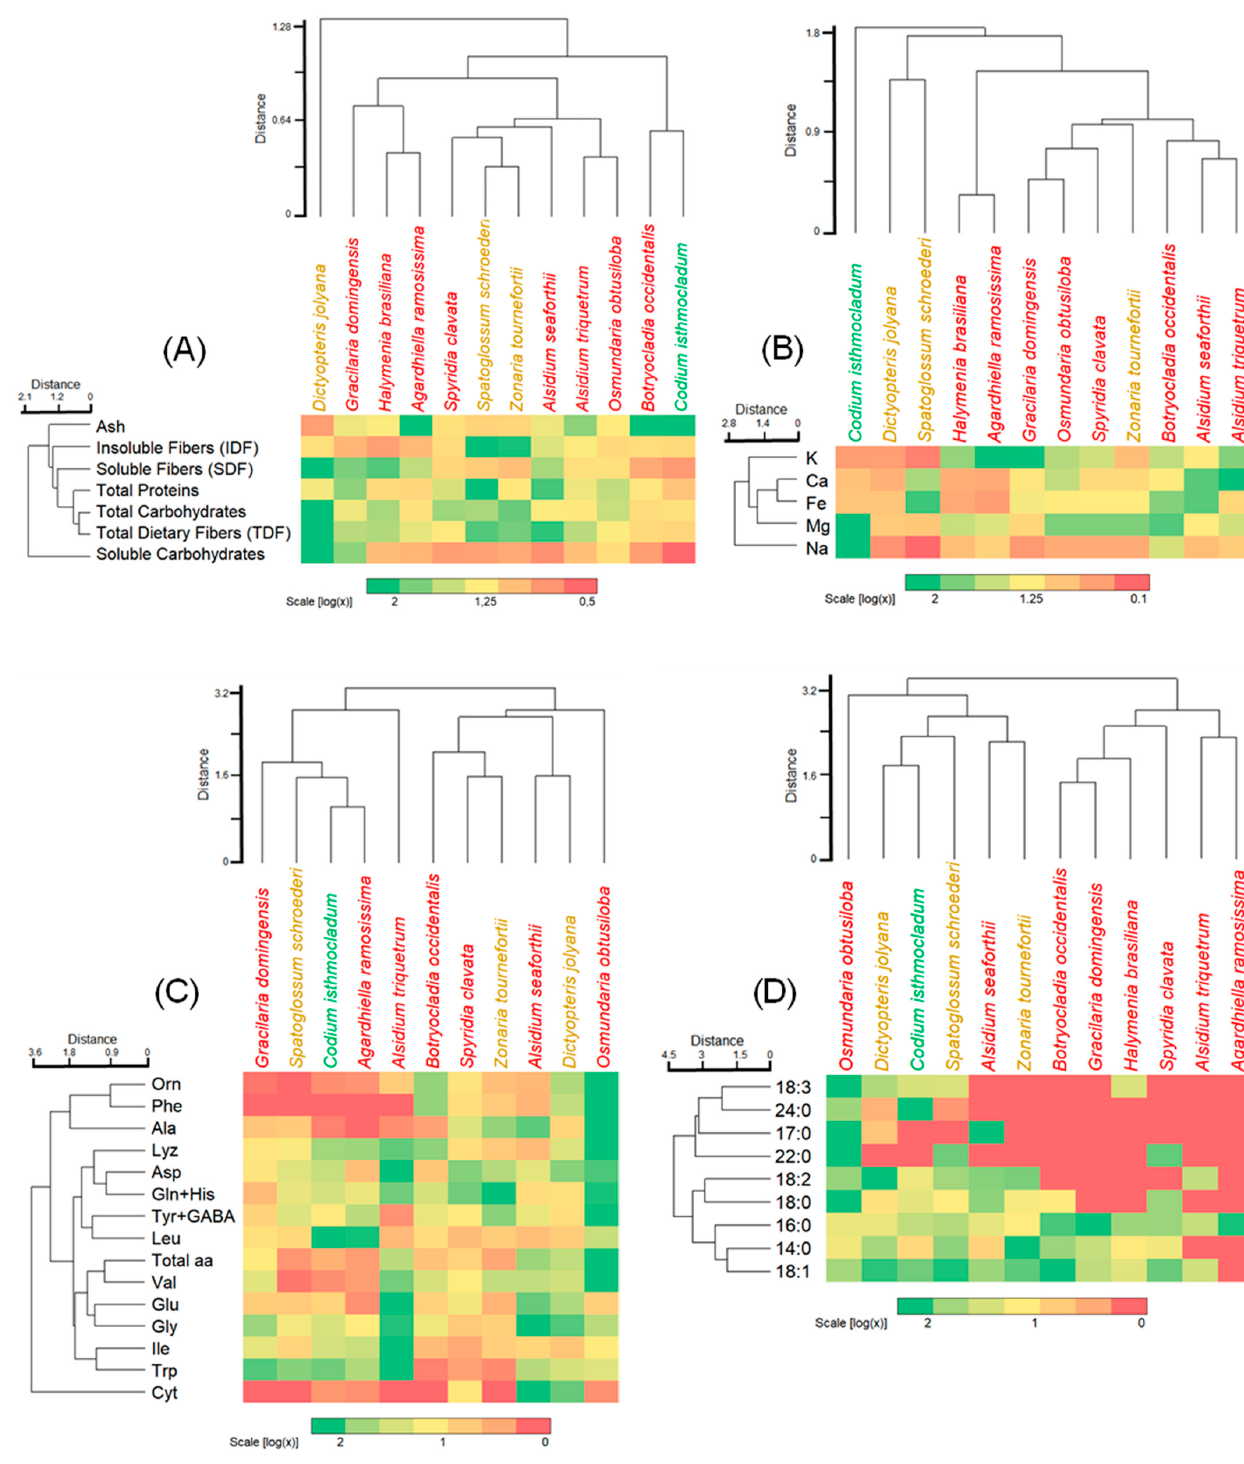
Figure 1. Heatmap of the biplot hierarchical Euclidean cluster analysis from beach-cast macroalgae for ( A ) proximate composition; ( B ) macro (Ca, K, Mg, and Na) and micro (Fe) elements; ( C ) free amino acid profile (amino acid values < 0.5 are represented as zero); ( D ) fatty acids composition (not detected fatty acids are represented as zero). Values represent the log transformation.